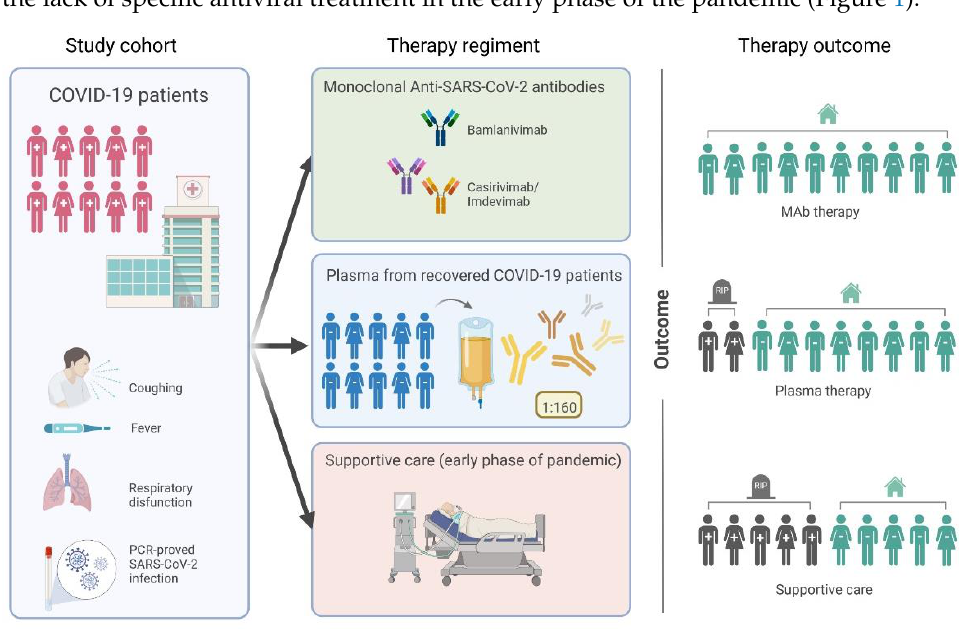
Figure 1. Study overview. Vulnerable patients at high risk for a severe course of COVID-19 were enrolled in the present study. The efficacy of monoclonal antibody treatment and convalescent plasma treatment was investigated and compared with best supportive care. As outcome parameter, 30-day mortality was